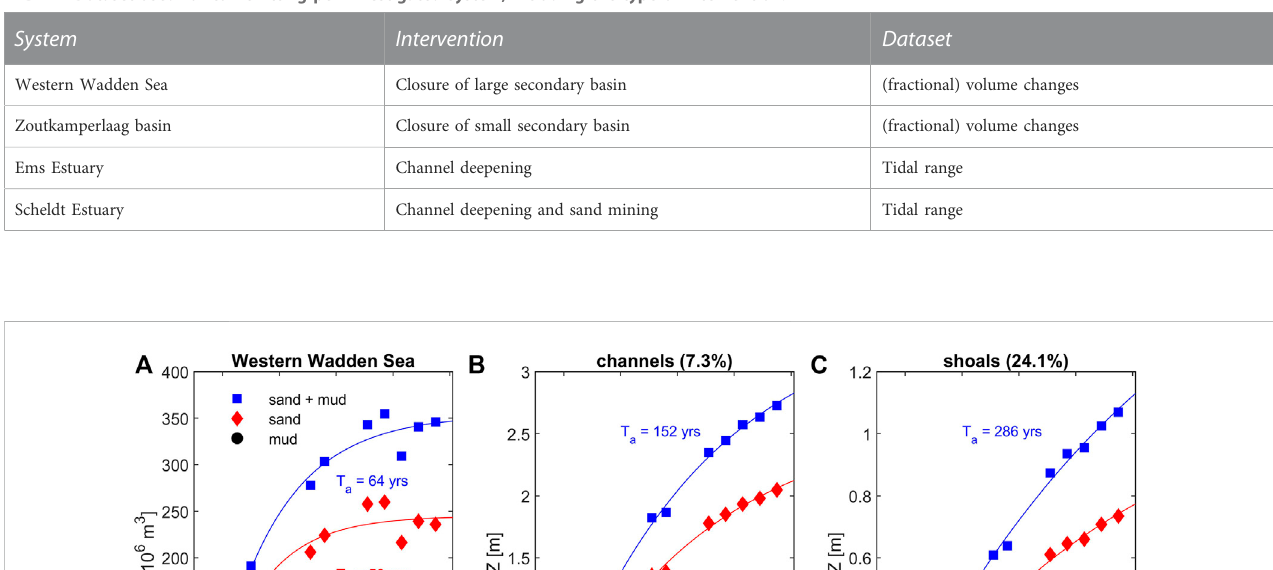
TABLE 1 Dataset used for curve fi tting per investigated system, including the type of intervention.